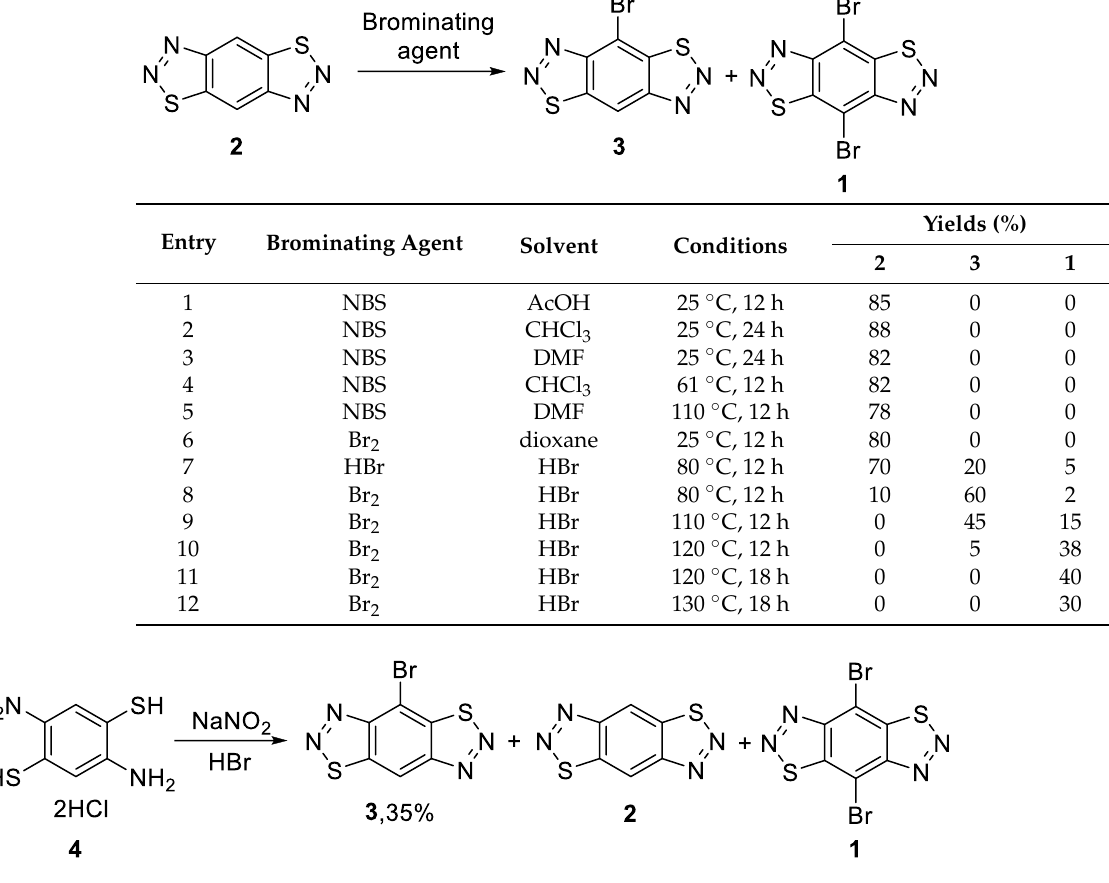
Table 1. Bromination of benzo[1,2- d :4,5- d ’]bis([1,2,3]thiadiazole) 2 .